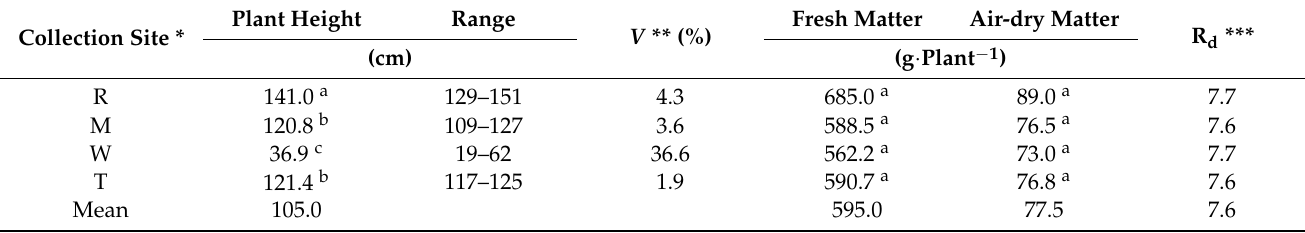
Table 2. Plant height and inflorescence weight values of wild-growing tansy plants.